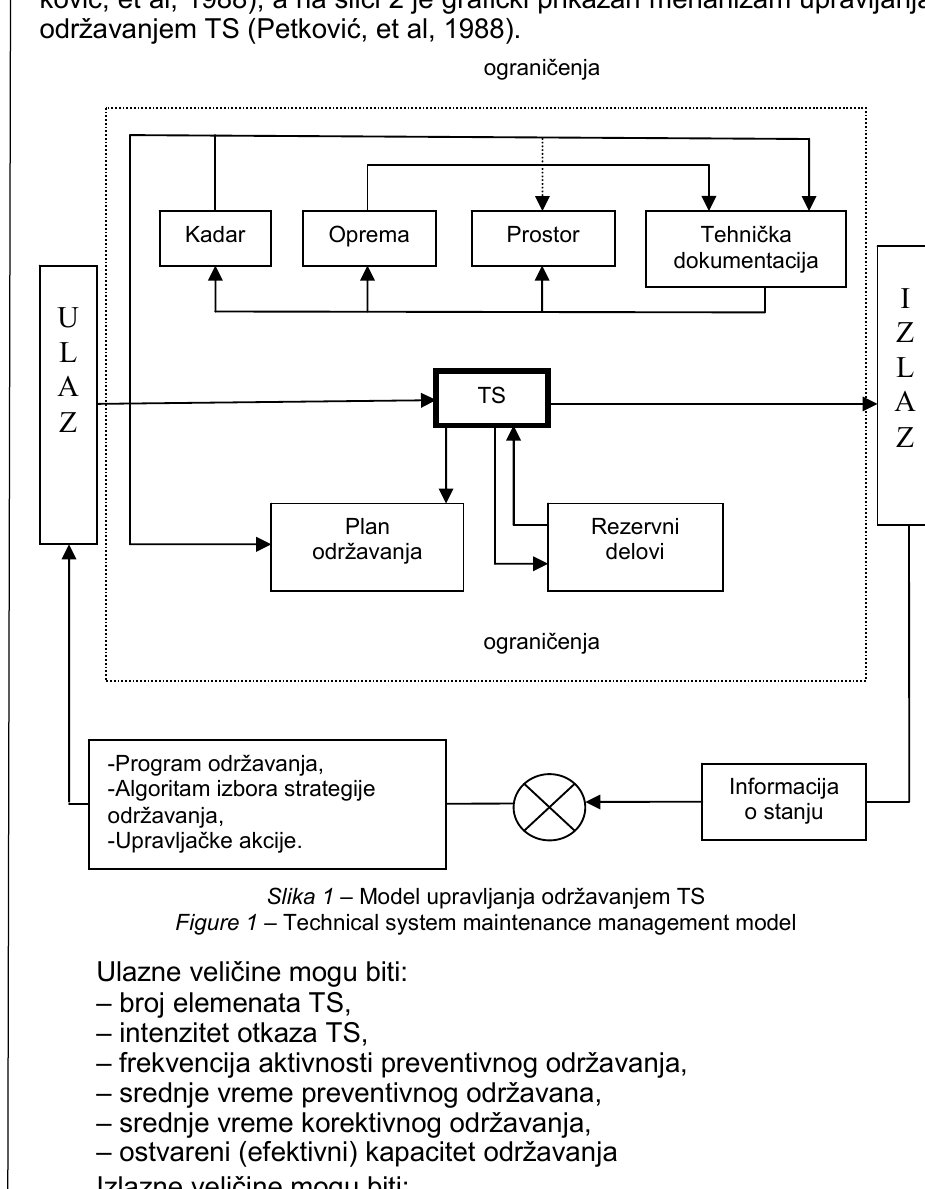
Figure 1 – Technical system maintenance management